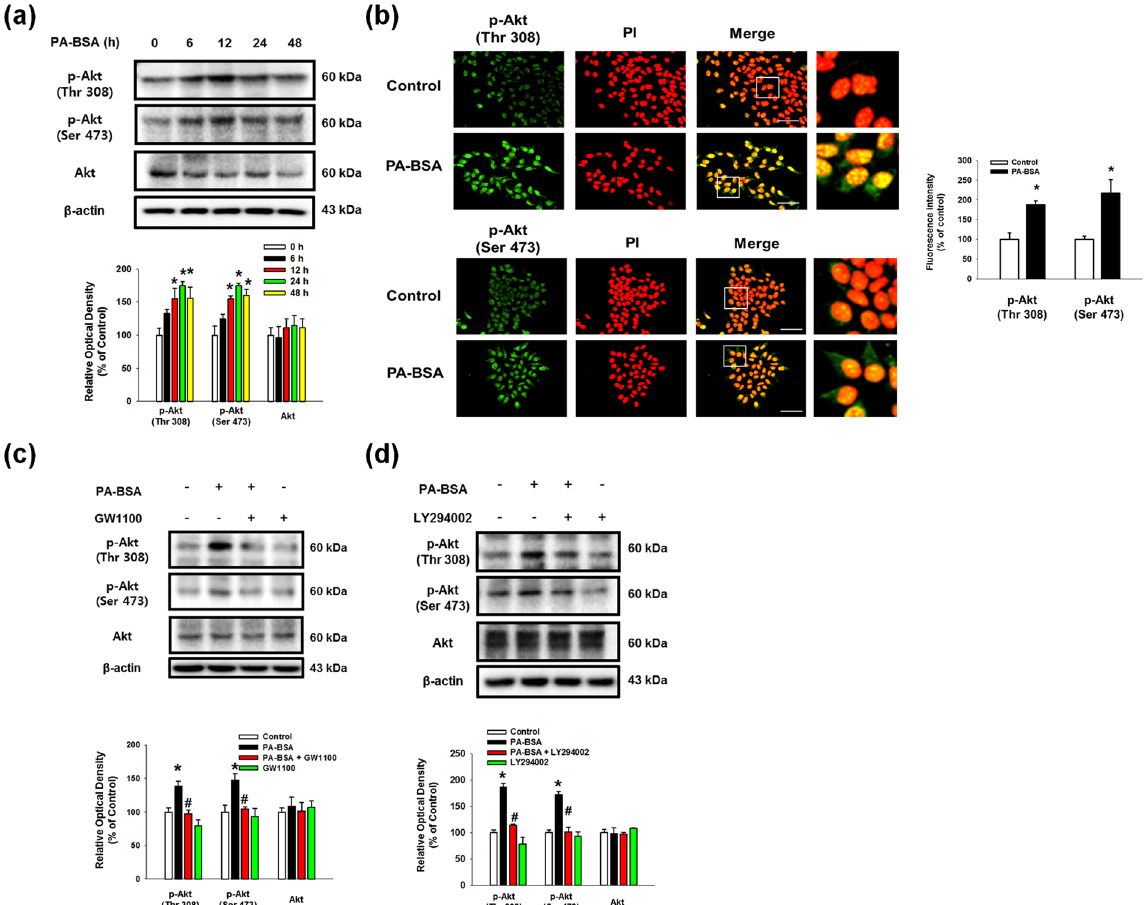
Figure 4. Role of PA-BSA in GPR40-mediated PI3K/Akt pathway. ( a ) SK-N-MC cells were exposed to PA-BSA (50 μ M) for 0–48 h. p-Akt (Thr308 and Ser473), Akt and β -actin expressions were detected by western blot. Data are reported as a mean ± S.E.M. n = 4 . ( b ) SK-N-MC cells were incubated with PA-BSA (50 μ M) for 24 h. Cells were immunostained with p-Akt (Thr308 and Ser473) antibodies and PI. All scale bars, 50 μ m (magnification, × 600). Fluorescence intensity data of p-Akt (Thr308 and Ser473) was reported as a mean ± S.E.M. n = 5 . All fluorescence images are representative. ( c and d ) SK-N-MC cells were pre-treated with GW1100 (10 μ M) and LY294002 (20 μ M) for 30 min prior to incubation with PA-BSA (50 μ M) for 24 h. Cells were blotted with p-Akt (Thr308 and Ser473), Akt and β -actin antibodies. Data are reported as a mean ± S.E.M. n = 4 . Each blot result shown is representative image. * p < 0.05 versus control, # p < 0.05 versus PA-BSA